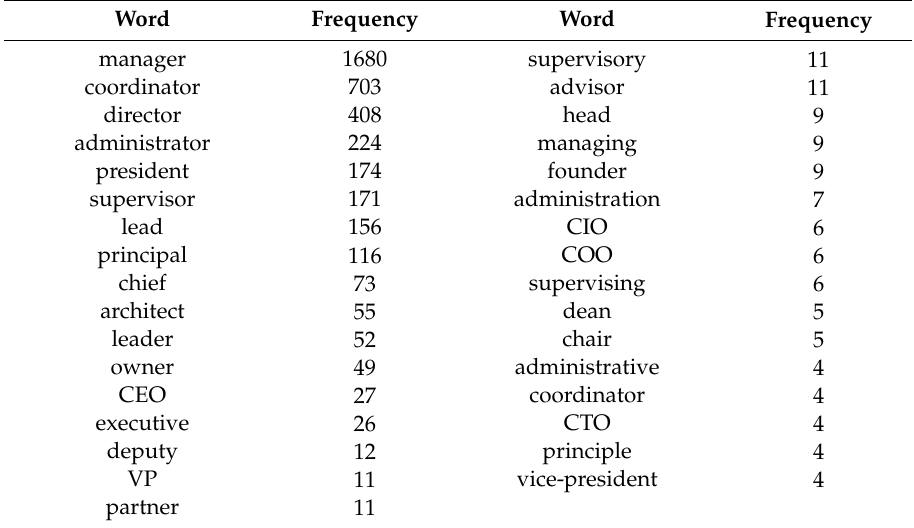
Table 4. A summary of the keywords that could indicate administrative roles. CEO: Chief Executive O ffi cer, VP: Vice President, CIO: Chief information o ffi cer, COO: Chief Operating O ffi cer, CTO: Chief Technology O ffi cer.